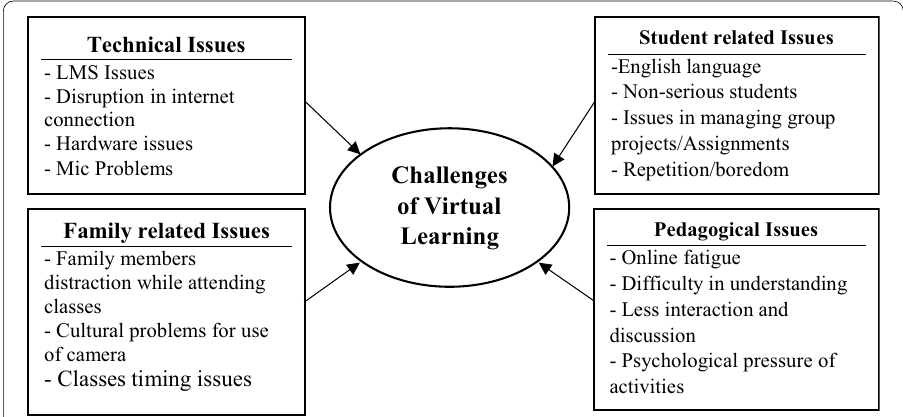
Fig. 4 Challenges associated with virtual learning